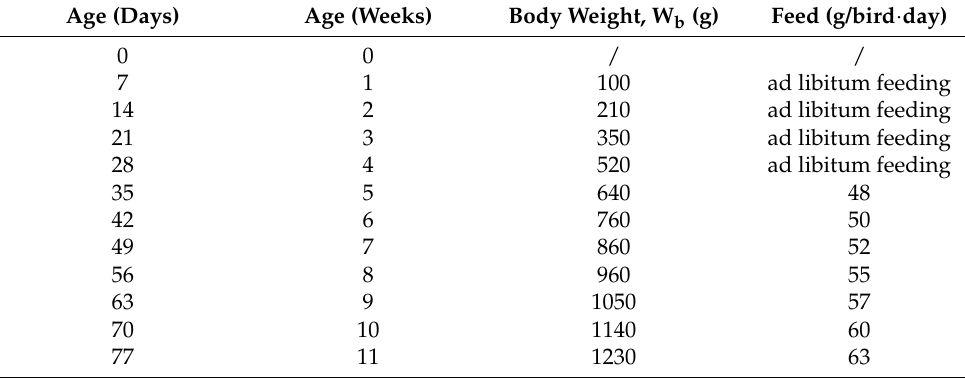
Table 2. Animal body weight and feeding strategies applied in the present